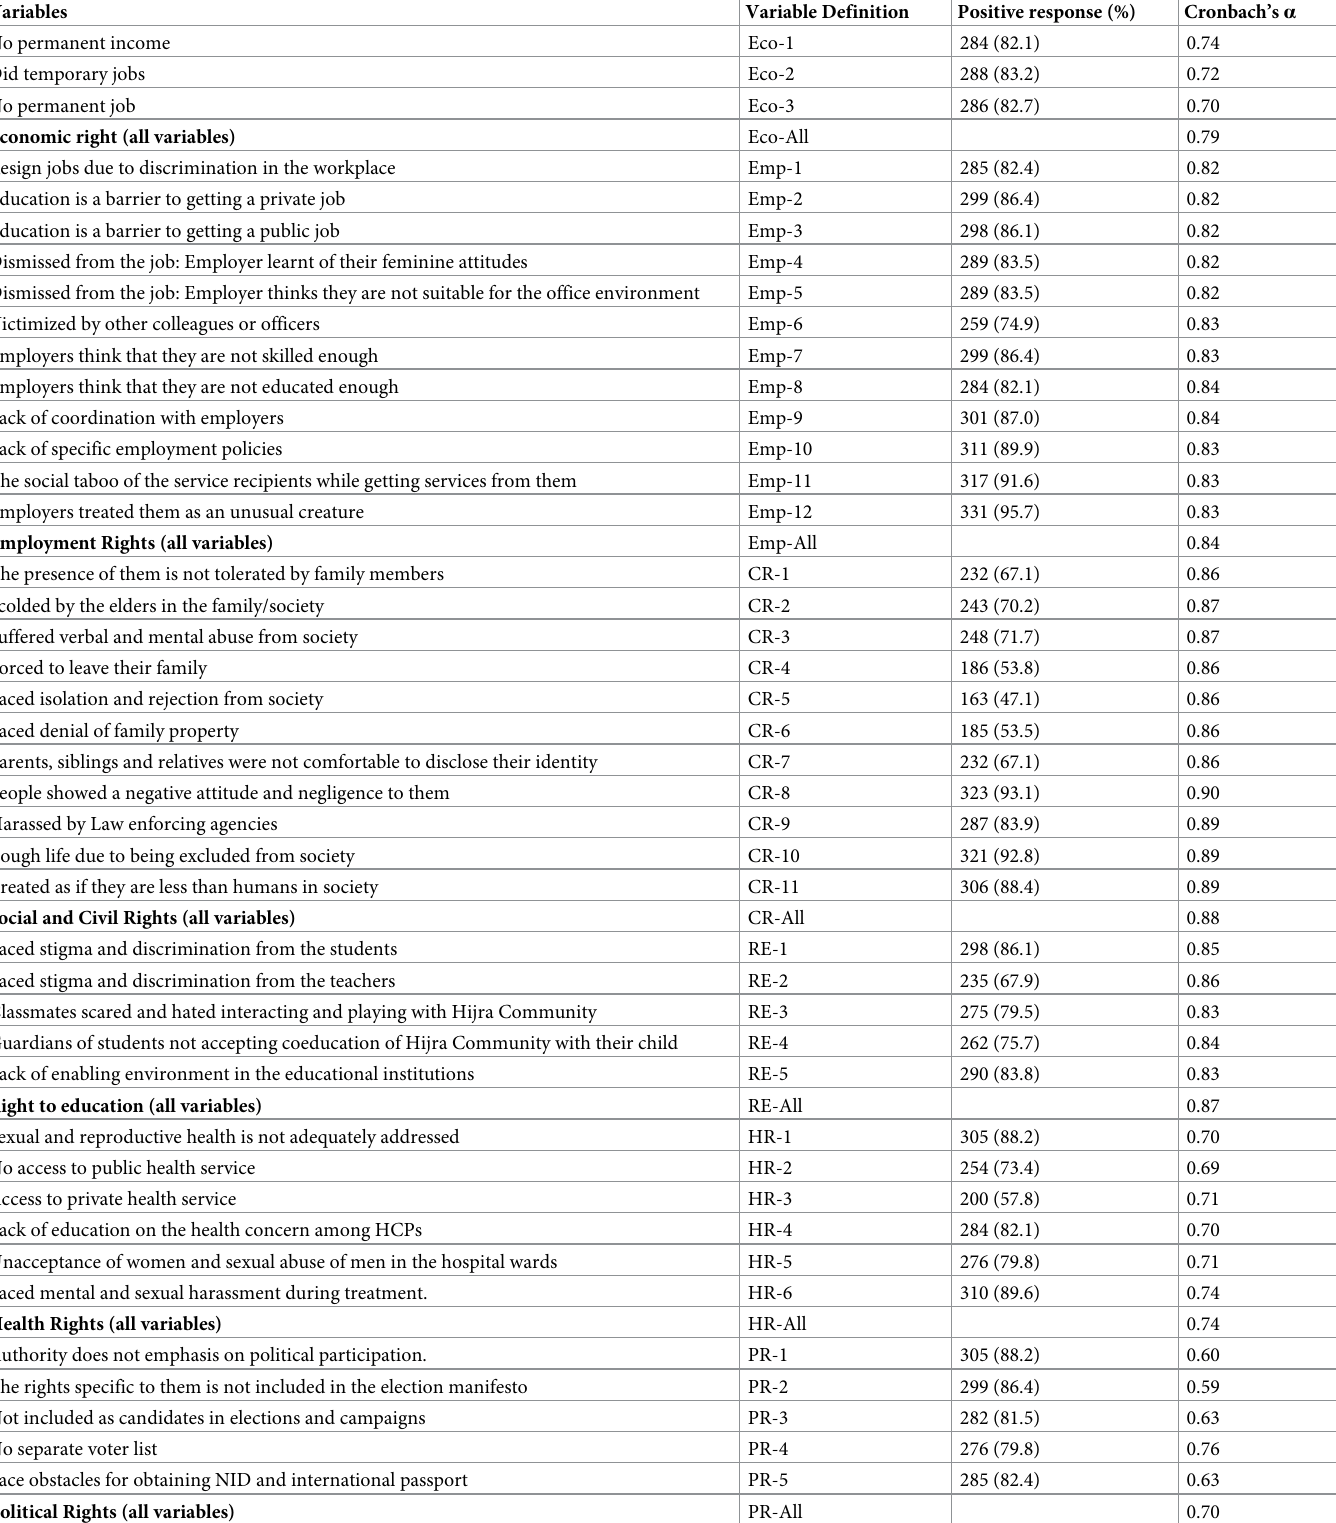
Table 1. Variable identification, Kuder-Richardson (KR) cronbach’s α of survey items and percentage responses of participants (n =